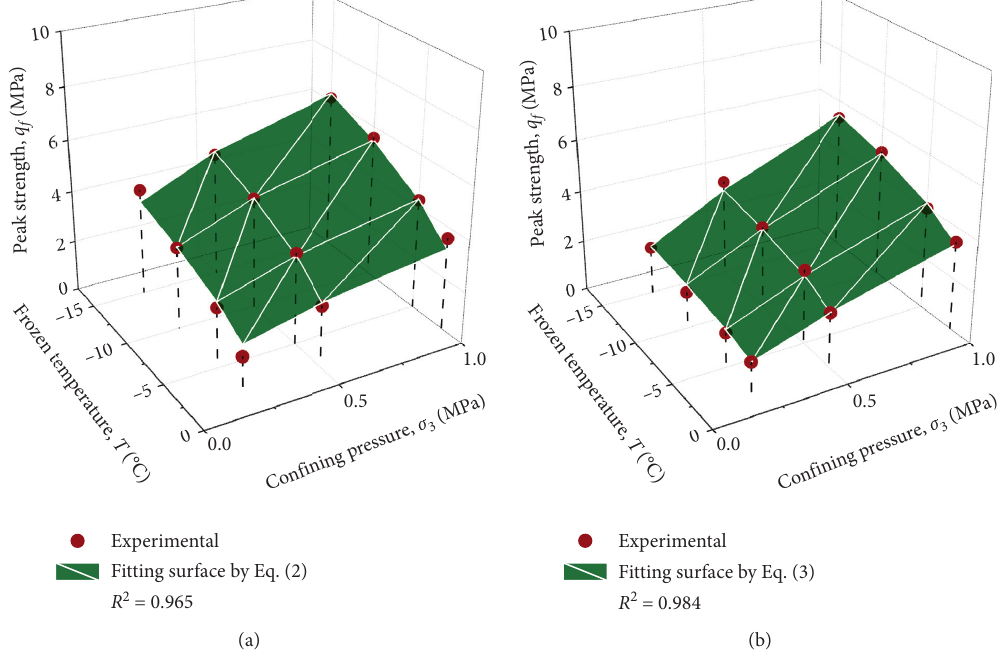
Figure 6: Variation in (a) peak strength and (b) residual strength versus frozen temperature and confining